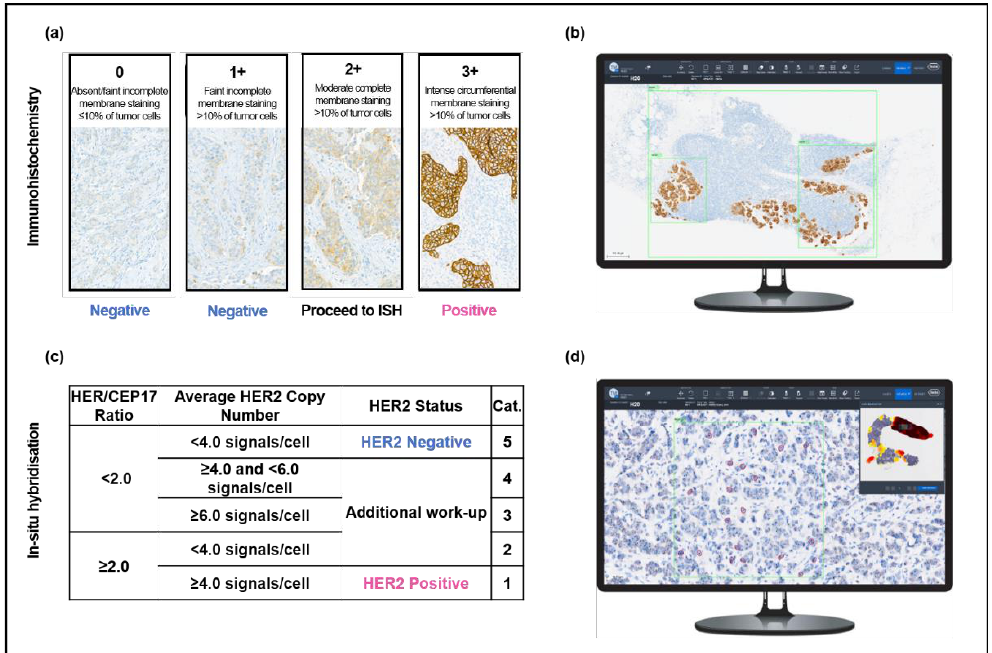
Figure 1. Overview of the study protocol for HER2 evaluation. Pathologists performed manual, light microscopic evaluation of HER2 ( a ) immunohistochemistry and ( c ) in situ hybridization in accordance with the 2018 ASCO/CAP guidelines. Slides were also analyzed with the support of two AI algorithms: AI-assisted immunohistochemistry analysis ( b ) was performed by placing three regions of interest (green) over tumor tissue and ( d ) AI-assisted in situ hybridization was analyzed by selecting a region of interest (green) within an area of high HER2 expression, as indicated by the heatmap (upper right). Within the region of interest, the algorithm calculated the HER2 and CEP17 signals for 20 cells (red).